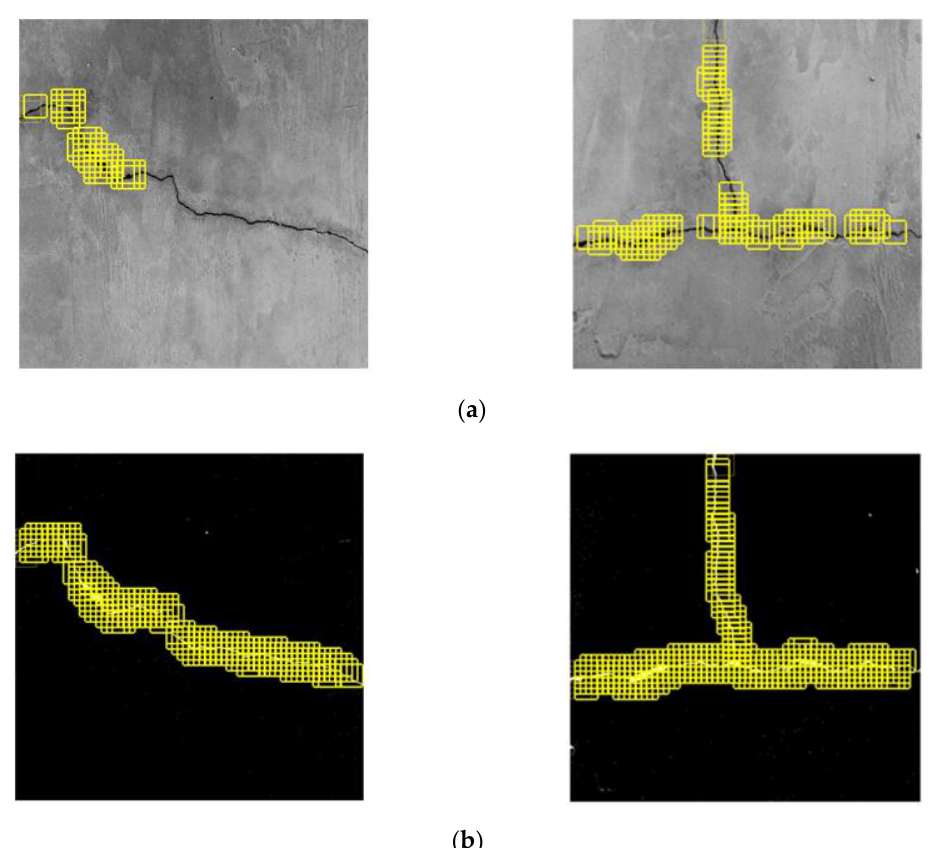
Figure 19. Crack position detection(CPD) effect based on ( a ) the original CPD and ( b ) MLP – CNN, under moderate level of noise influence.